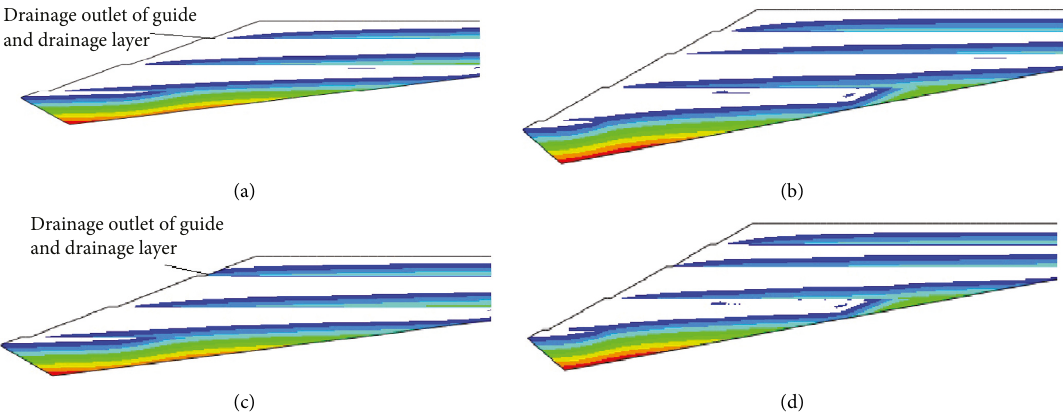
Figure 9: Leachate level distribution in Scheme 1 (a, b) and leachate level distribution in Scheme 4 (c, d). (a) Landfill to the fourth layer (Scheme 1). (b) Landfill to the fifth layer (Scheme 1). (c) Landfill to the fourth layer (Scheme 4). (d) Landfill to the fourth layer (Scheme